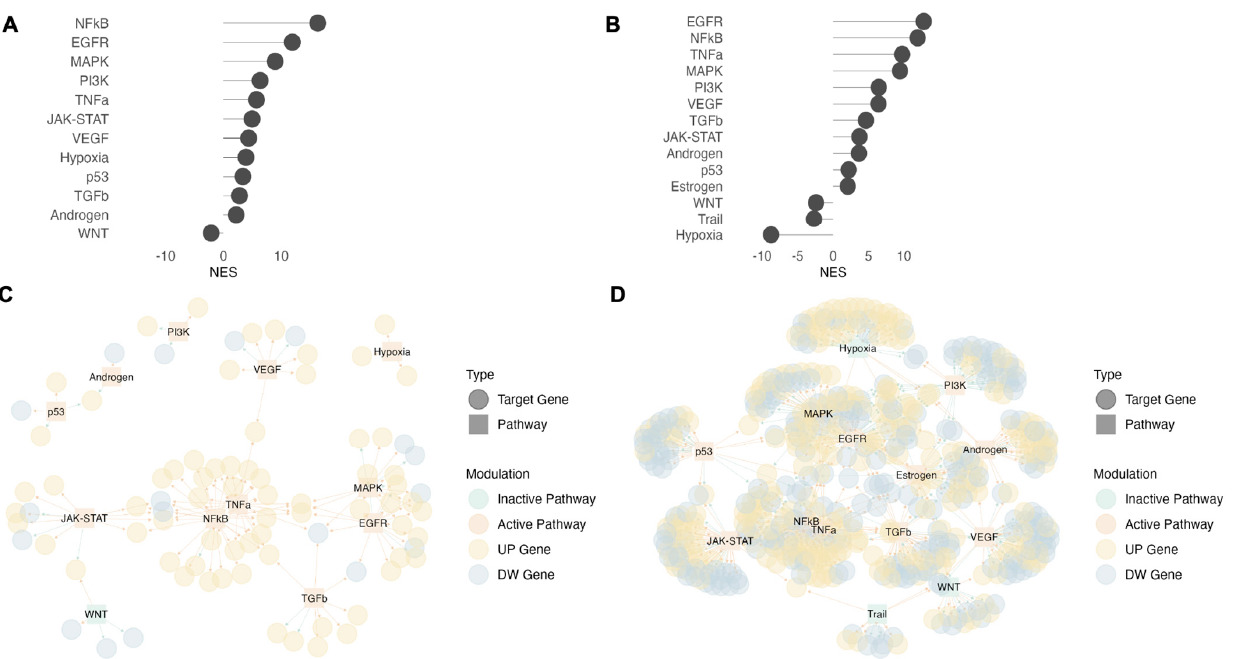
Figure 5. Differentially activated pathways between ST and US conditions using PLSM ( A ) and RPMI ( B ). Networks connecting pathways activated (orange rectangle) or repressed (green rectangle) after stimulation with the relative up-regulated (yellow circle) or down-regulated (blue circle) genes both in PLSM ( C ) and in RPMI ( D ). The connections between pathways and DEGs nodes and their mode of regulation (positive in orange or negative in green) are information from the PROGENy database.